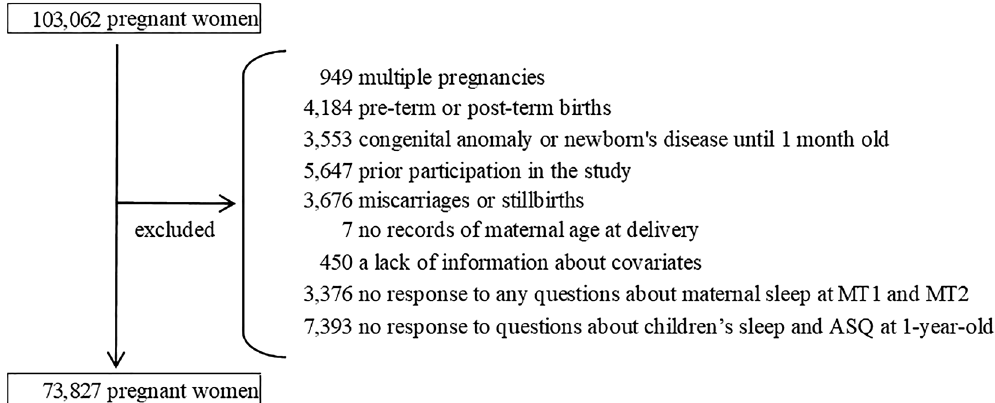
Figure 1. Flow chart representing the study population. MT1 questionnaire administered at recruitment, MT2 questionnaire administered during mid- or late-pregnancy, ASQ the Ages and Stages